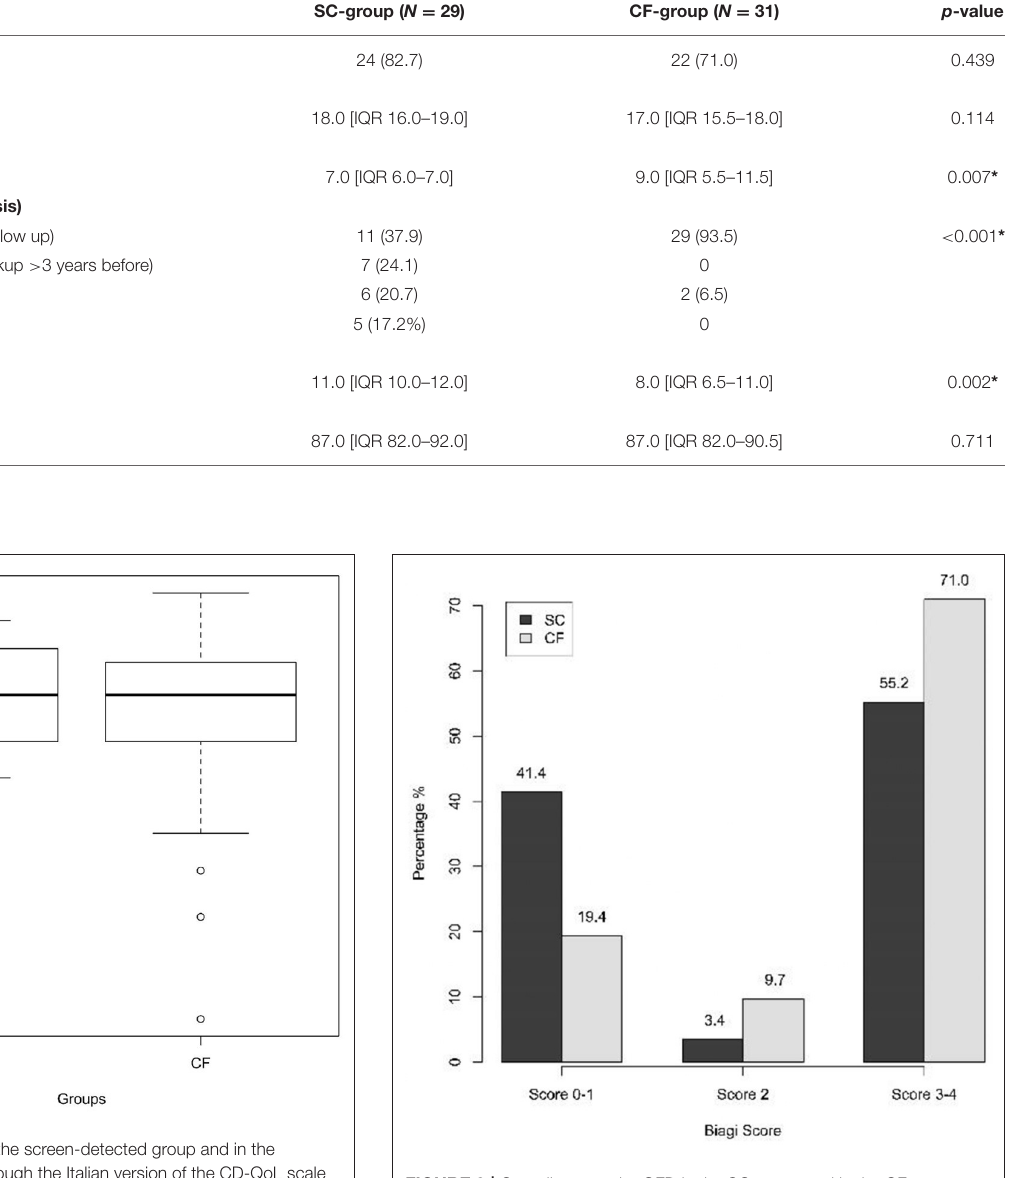
lower than the percentage observed in the CF-group ( p < 0.001) ( Figure 4